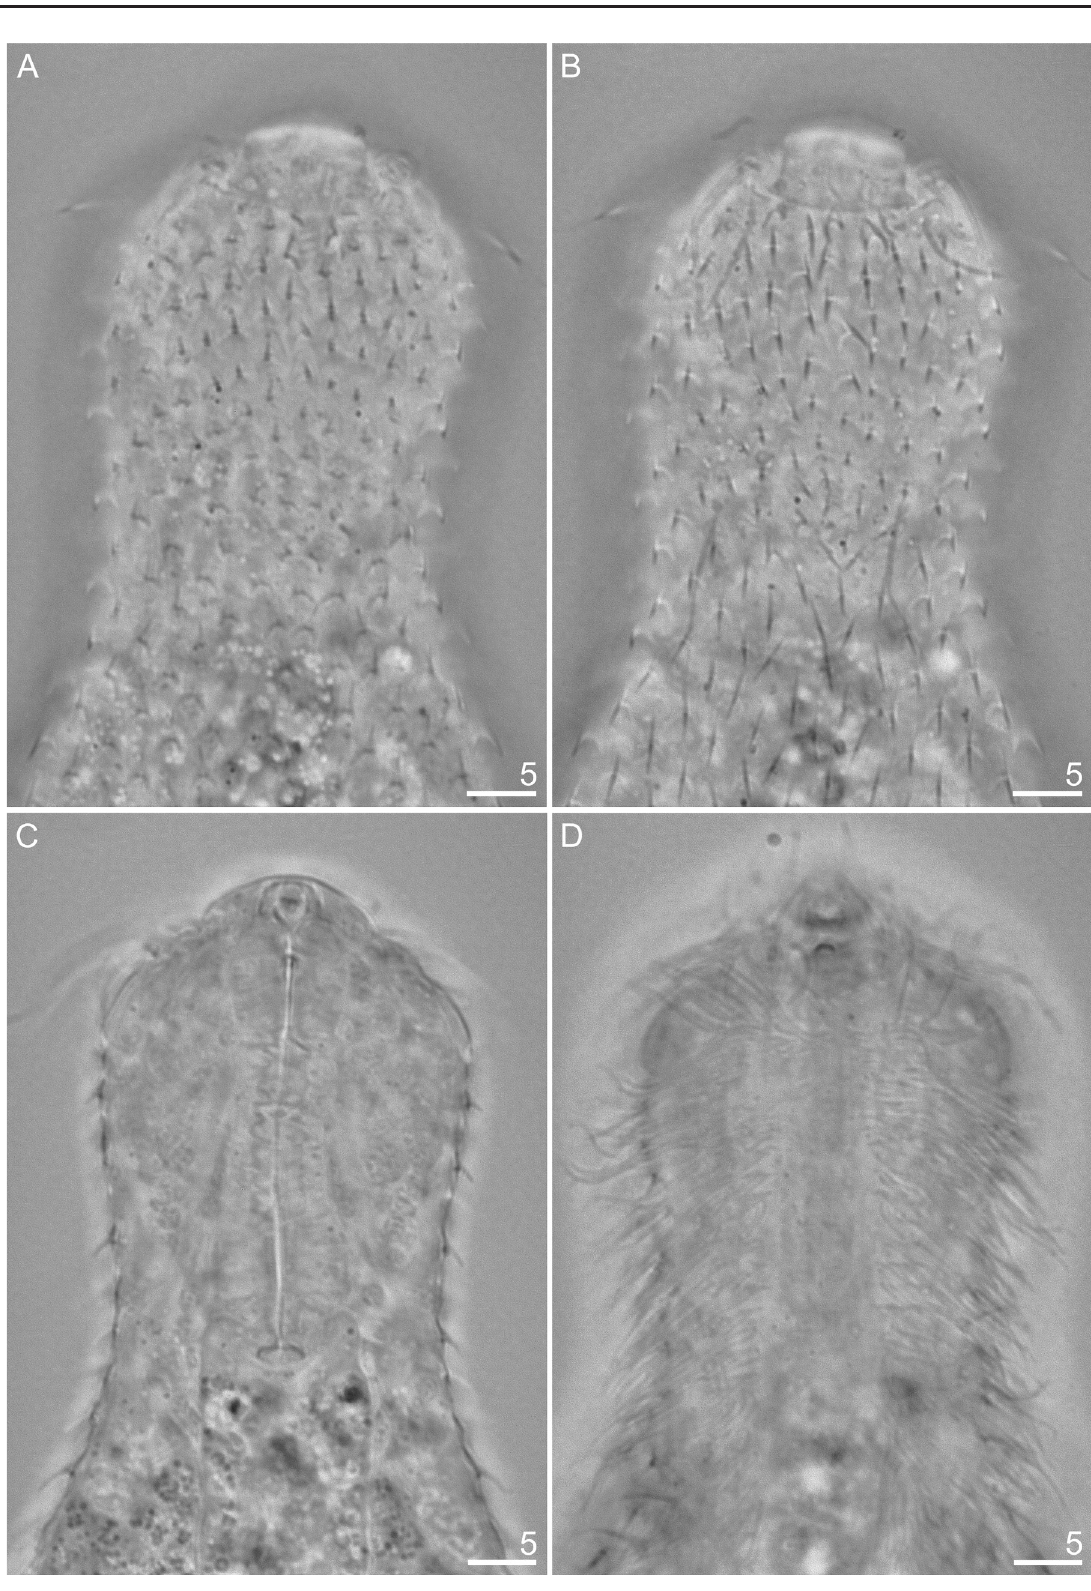
Fig. 7. Chaetonotus (Chaetonotus) antrumus Kolicka sp. nov. A . Dorsal view of scales on head and neck. B . Dorsal view of spines on head and neck. C . Internal view of head and neck. D . Head and neck, ventral view. (Bright field